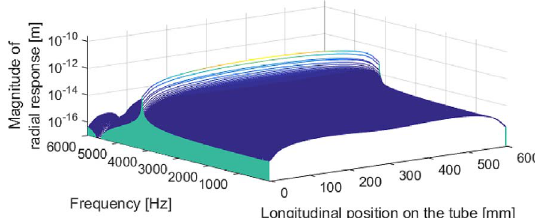
Figure 16. De fl ection in a symmetric tube, excited by unitary internal pressure.